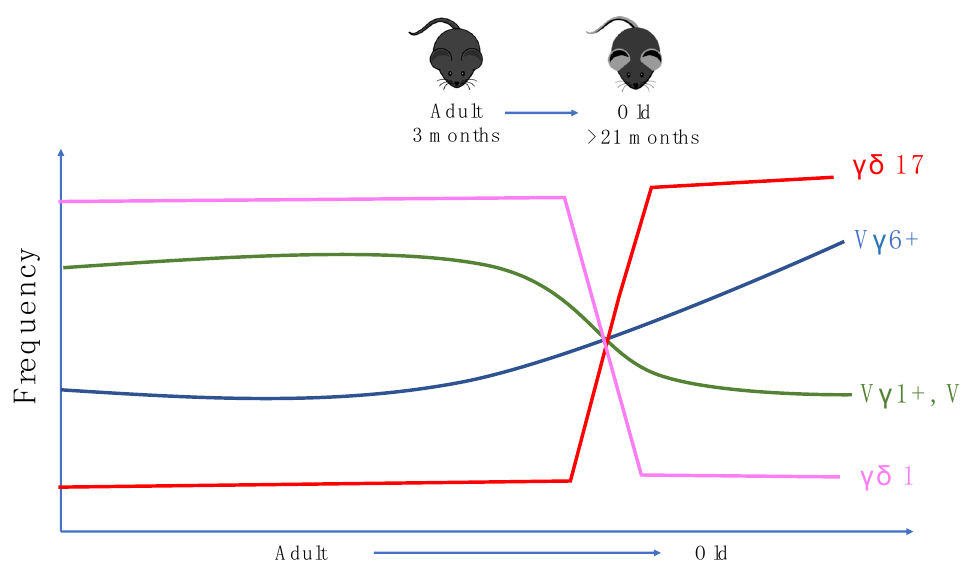
Figure 2. Alterations in the cytokine profile and γ chain utilization of mice γδ T cells in peripheral lymph nodes with age.